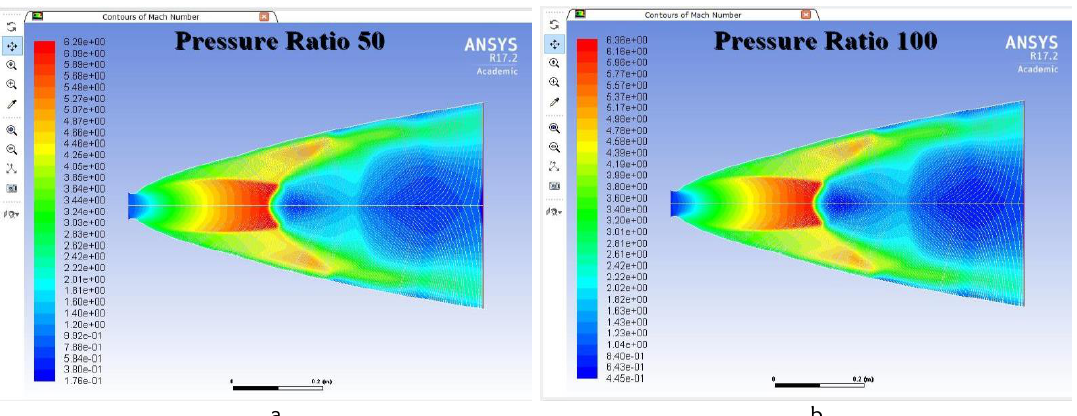
Figure 8: Contour of Mach number for pressure ratio 50 (a) and 100 (b)